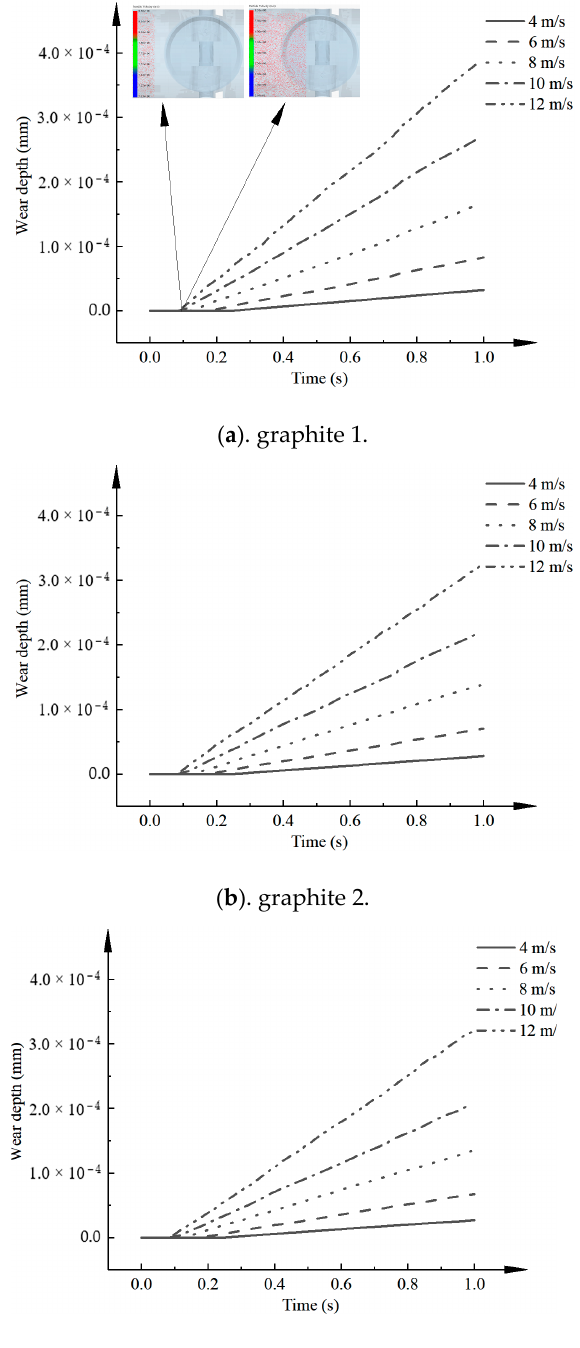
Figure 16. Folding graph of the total wear of the sealing surface at different speeds.